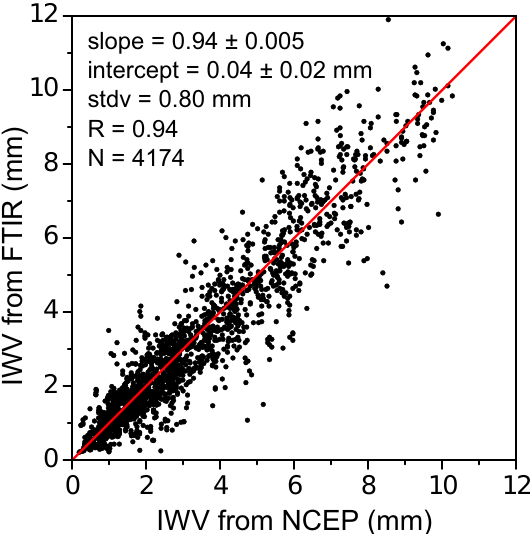
Fig. 10. Intercomparison of integrated water vapor (IWV) above the Zugspitze retrieved from the solar FTIR with the strategy of Sussmann et al. (2009) versus integrated water vapor profiles from NCEP. Four-times-daily NCEP profiles were interpolated to the times of the FTIR measurements.